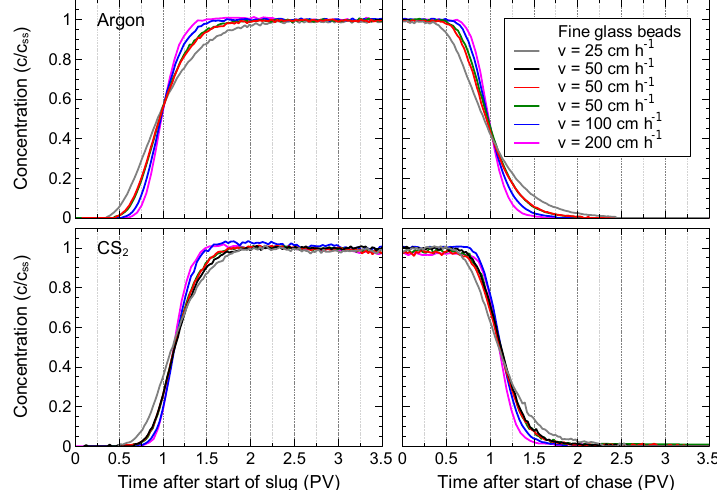
Figure 5. Breakthrough curves of CS 2 and Ar in moist fine glass beads ( S w = 0.088) for different velocities.